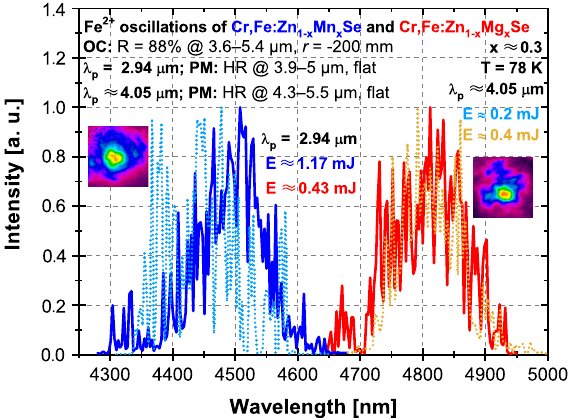
Figure 11. The comparison of the Fe 2 + ions’ laser oscillations of the Cr,Fe:Zn 1 − x Mn x Se and Cr,Fe:Zn 1 − x Mg x Se (x ≈ 0.3) laser systems for two different direct excitation wavelengths λ p =2.94 µ m and λ p ≈ 4.05 µ m (all at 78K). λ p =2.94 µ m: Cr,Fe:Zn 1 − x Mn x Se and Cr,Fe:Zn 1 − x Mg x Se (x ≈ 0.3)—full blue line and full red line curves,